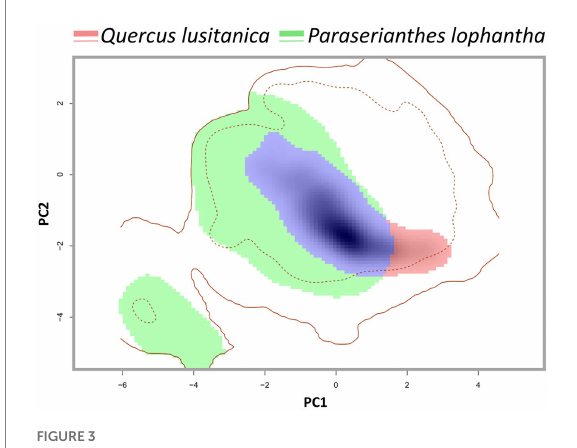
FIGURE 3 Fine-scale study of niche overlap between Paraserianthes lophantha and Quercus lusitanica in Monte Pindo. Solid and dotted contour lines represent 100 and 50% of the available environmental conditions that exist in available environment in Monte Pindo. Green areas represent climates only occupied by P. lophantha , blue areas indicate climates occupied both by the native Q. lusitanica and the introduced P. lophantha , red areas represent climates only occupied by Q. lusitanica . Shading indicates the density of